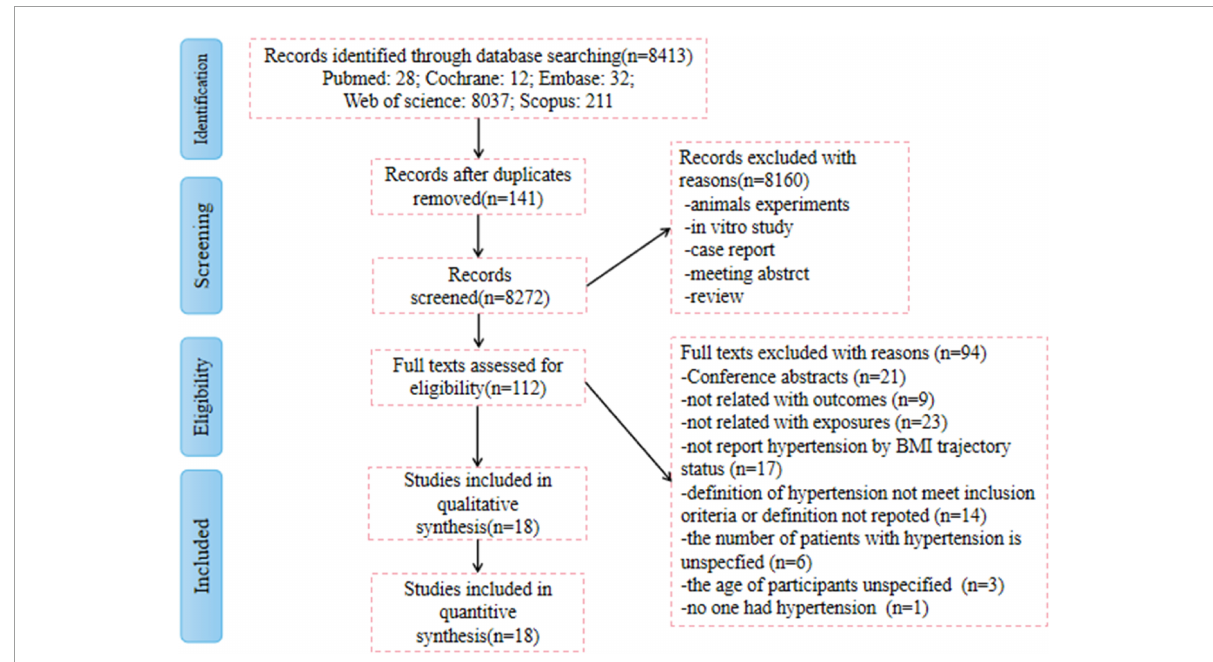
FIGURE1 Preferred Reporting Items for Systematic Reviews and Meta-Analyses (PRISMA) flow diagram of the study selection